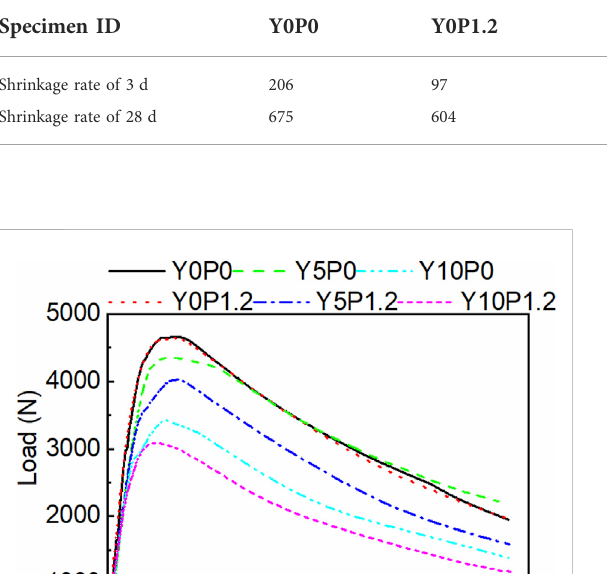
TABLE 4 Autogenous shrinkage rate at 3 d and 28 d